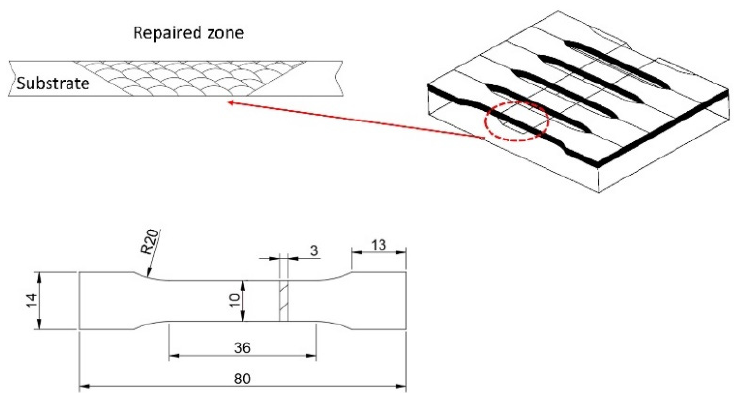
Figure 2. Drawing of distribution of laser-repaired zone in the tensile specimen and its dimensions.